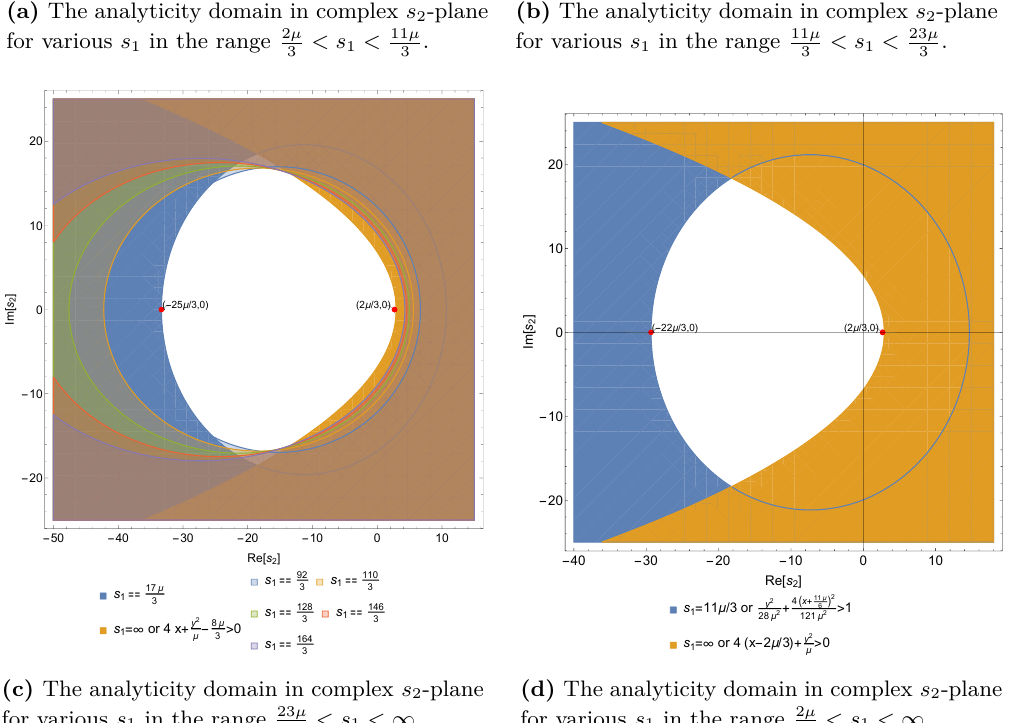
Figure 7. Lehmann-Martin ellipses. Shaded region is excluded.